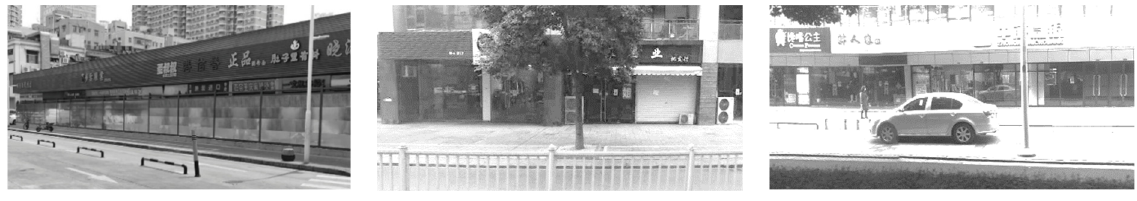
Figure 7. Closed shops on the roadside.